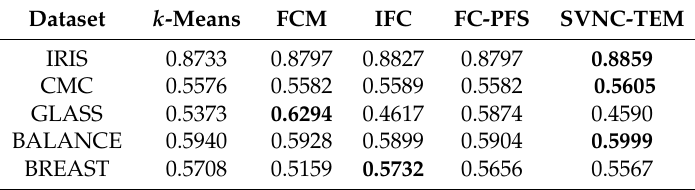
Table 4. The RI for different algorithms on different